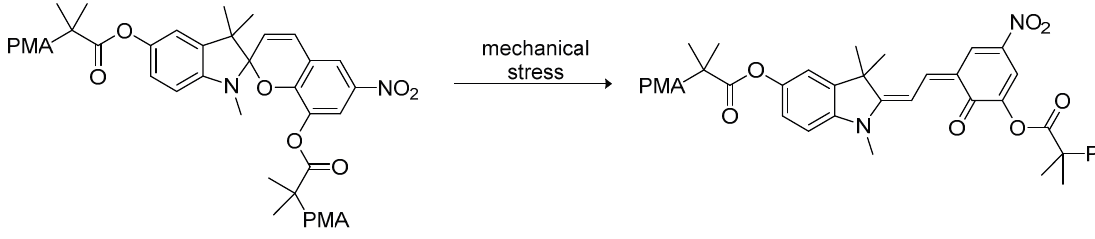
Figure 12. The ring-opening reaction of a spiropyran-poly(methyl acrylate) (PMA) polymer due to mechanical stress